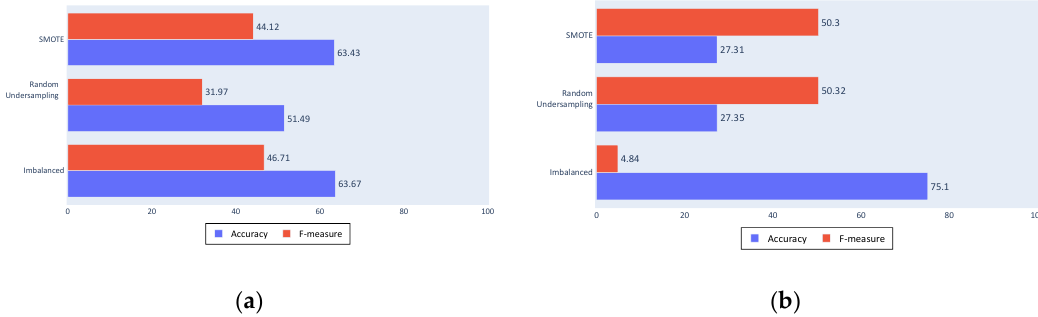
Figure 13. ( a ) No cleaning decision tree results; ( b ) No cleaning SVM results.